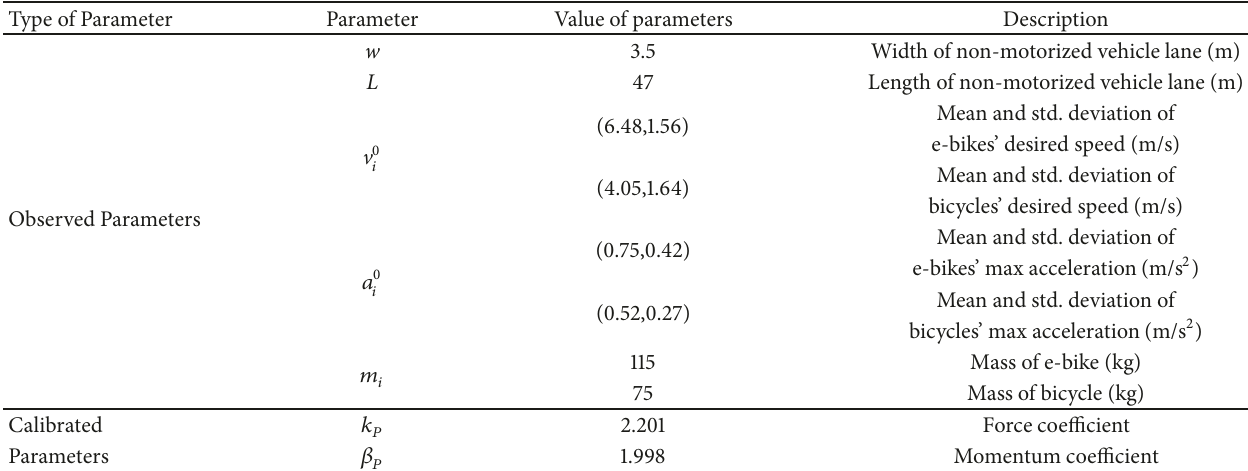
Table 4: Observed and calibrated parameters of the